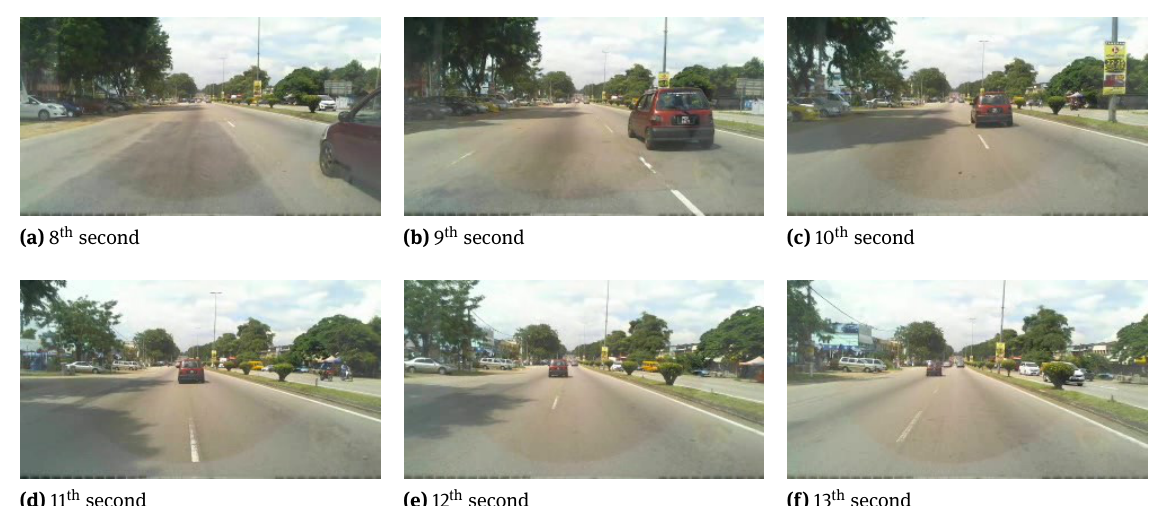
Figure 7: Corresponding road footages of clip